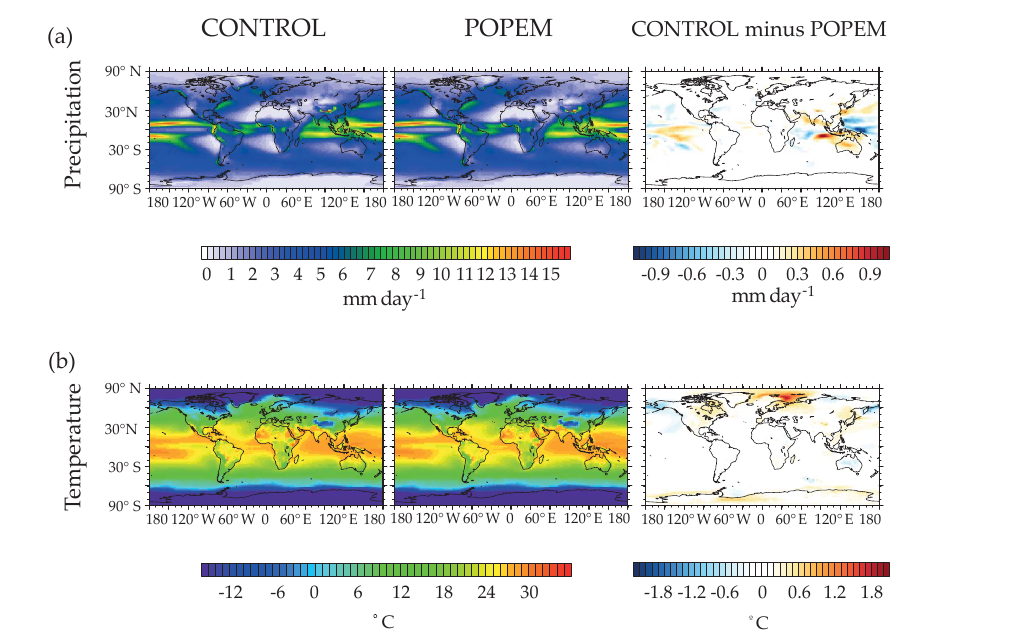
Figure 6. A comparison of global annual mean precipitation (1950–2000) for the CONTROL and POPEM (a) . (b) is a comparison of annual mean surface temperatures. The maps in the right-hand column show the absolute differences between the simulations (CONTROL minus POPEM). In these, blues represent higher values in POPEM and reds represent higher values in the CONTROL.